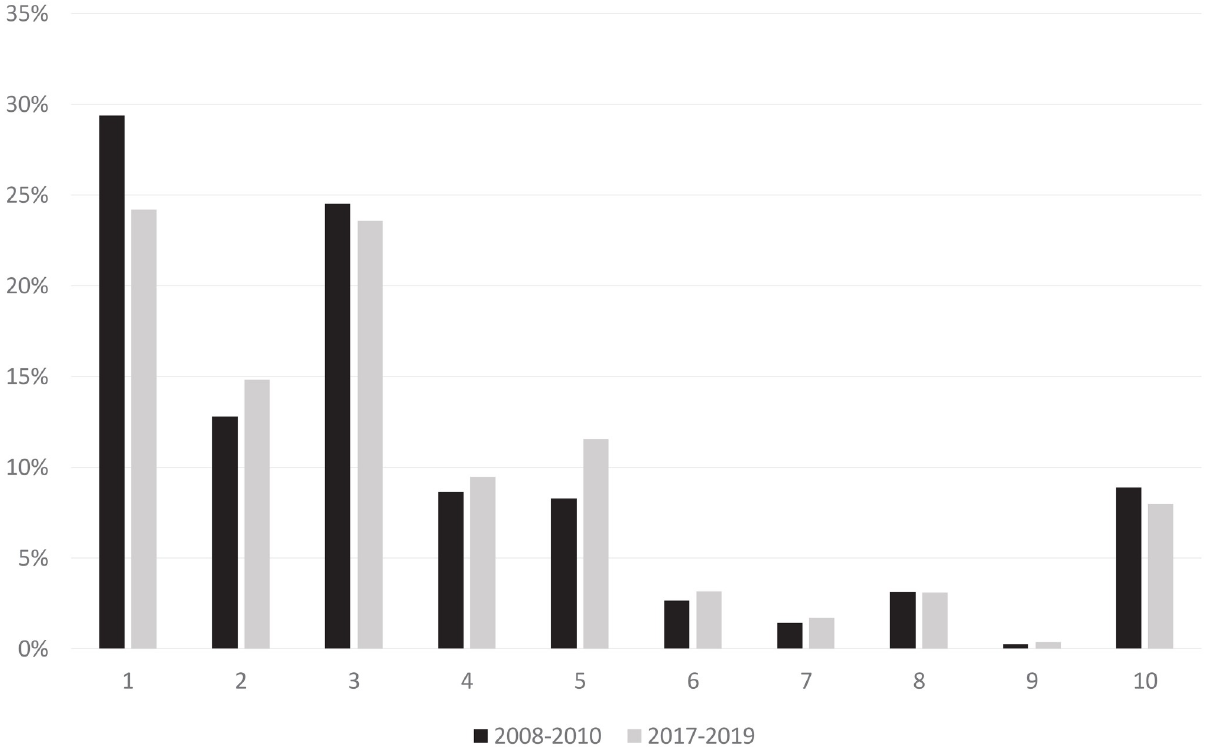
Fig 1. Group size. Comparison of the total number of births in each group between the years 2008–2010 and 2017–2019 using the ten group classification system by M. Robson (data in percentage).